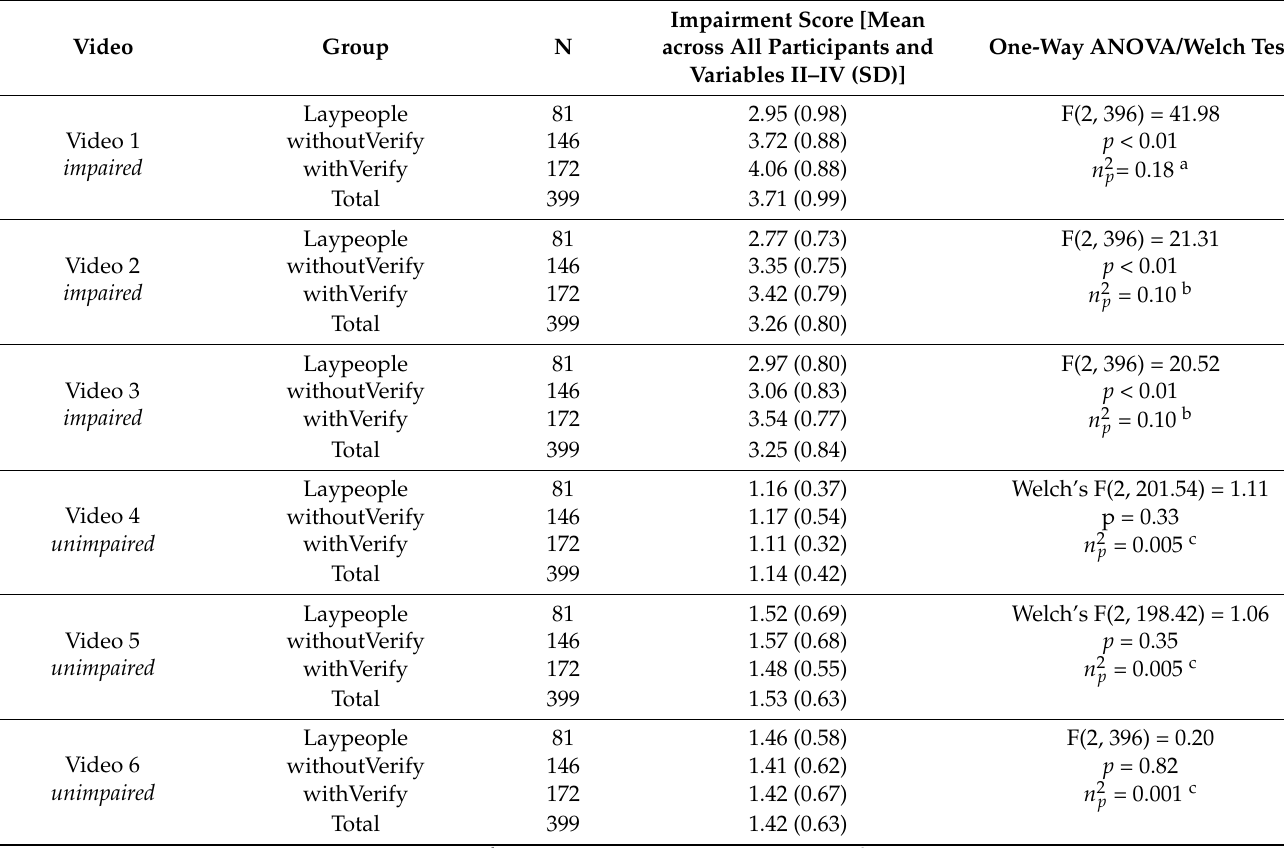
Table 6. Comparison of reported impairment severity between